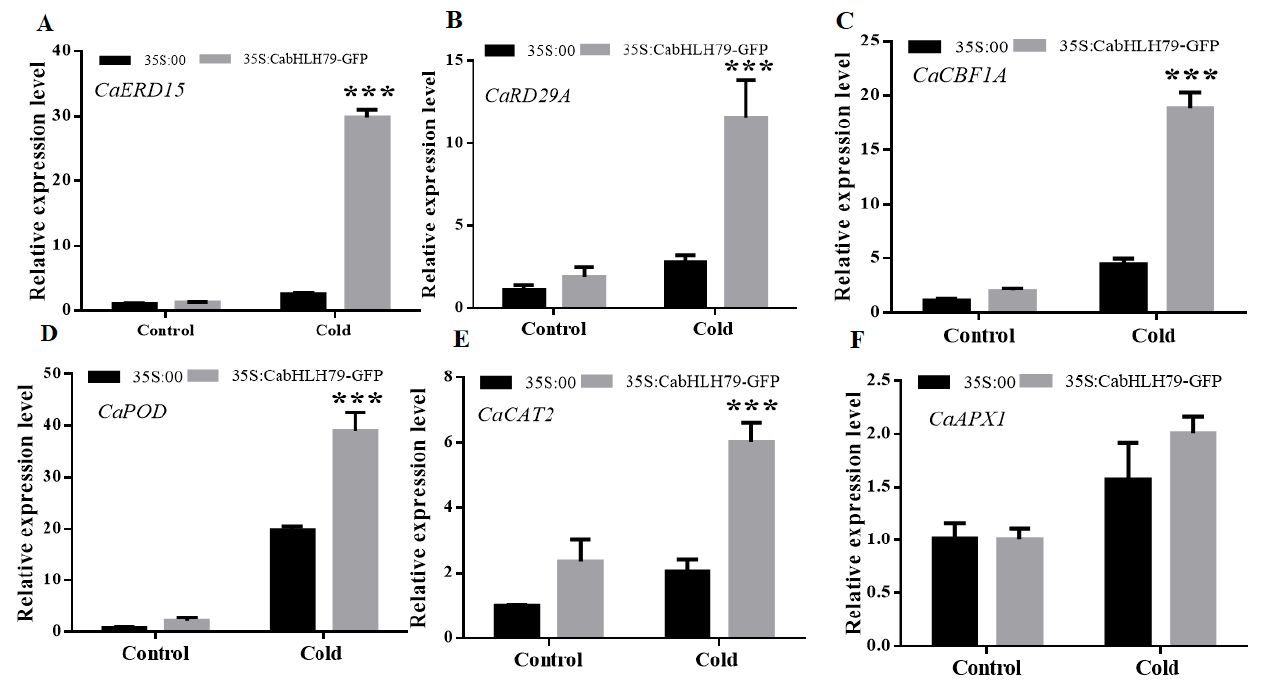
Figure 5. Transcription levels of cold-related genes and ROS-related genes. ( A – F ) RT-qPCR analysis of CaERD15 , CaRD29A , CaCBF1A , CaPOD , CaCAT2 , CaAPX1 . All data of three independent biological replicates were expressed by Means ± SDs. * representing significant difference (*** p < 0.001). 2.6. Overexpression of CabHLH79 in Arabidopsis Enhances Tolerance to Cold Stress ture stress, 4-week-old Arabidopsis were treated at 4 ◦ C for 3 days. WT plants showed